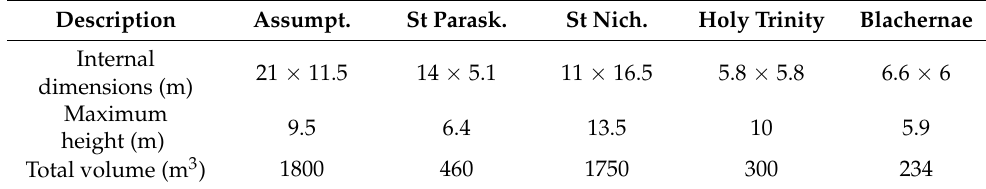
Table 1. Architectural characteristics of the Albanian churches in Byzantine